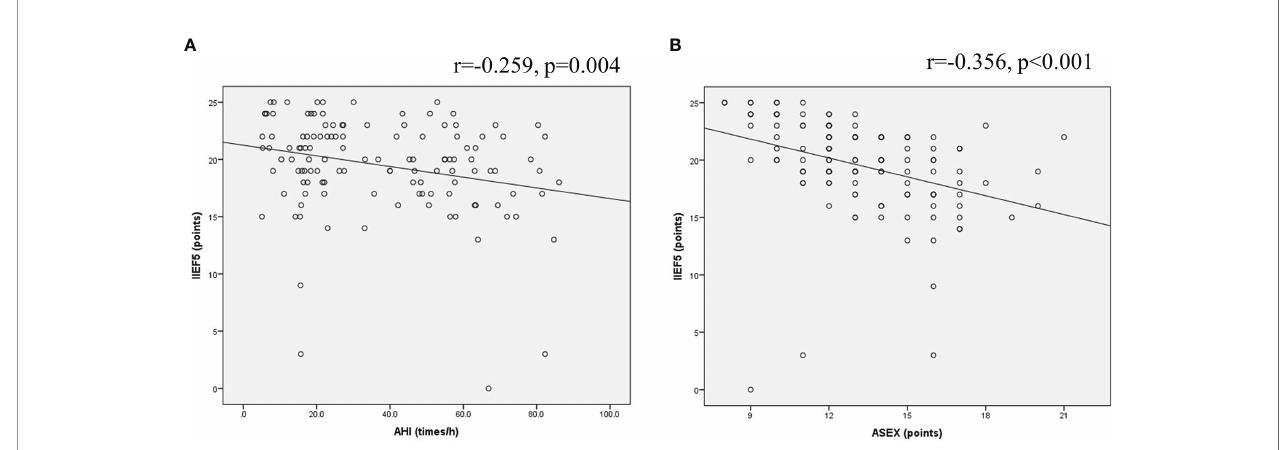
FIGURE 6 | Scatter plot of the relationship of OSA patients. (A) The IIEF-5 scores of 124 OSA patients were negatively correlated with the AHI value; (B) The IIEF-5 scores were negatively correlated with the ASEX